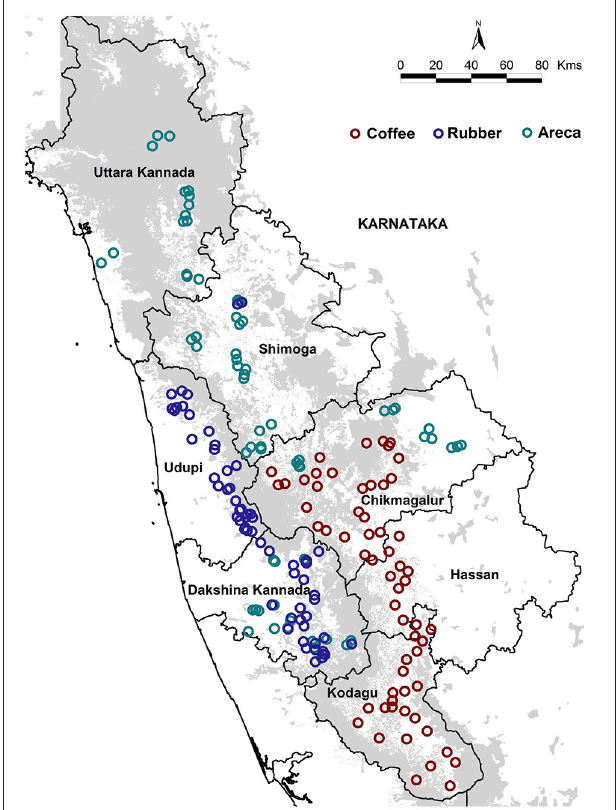
FIGURE 1 | Locations of all sampled areca, coffee and rubber agroforests in India’s Western Ghats.